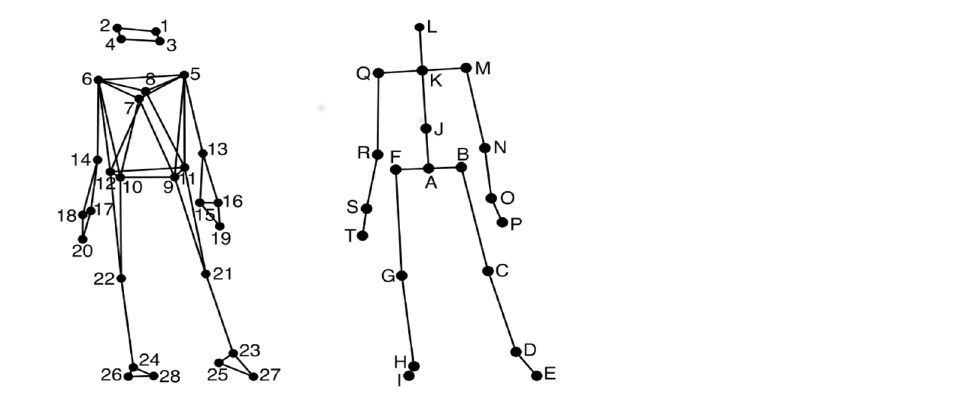
Figure 8. Dataset-2: Anterior view of the location of the markers attached to the participants’ bodies; Anterior view of the locations of the secondary markers/joints used in the